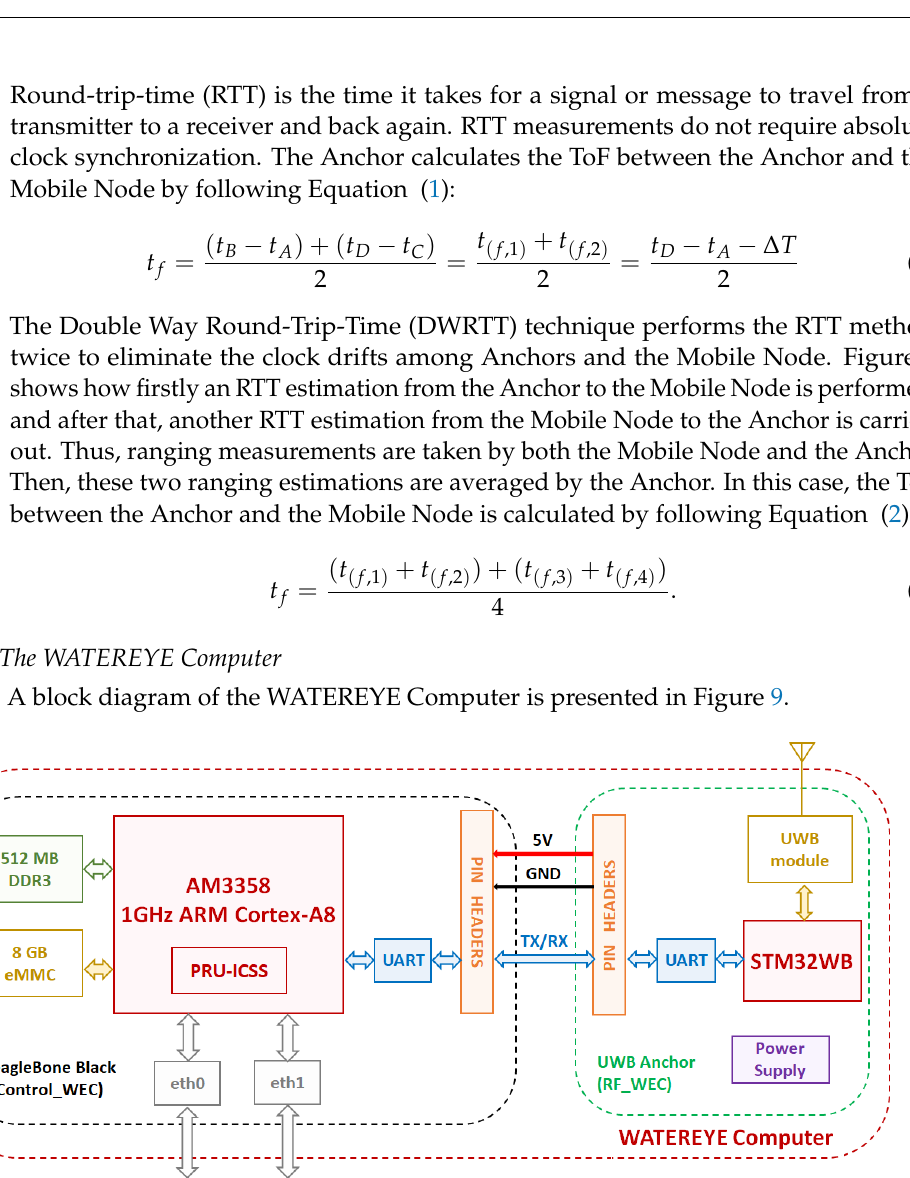
Figure 9. WATEREYE Computer